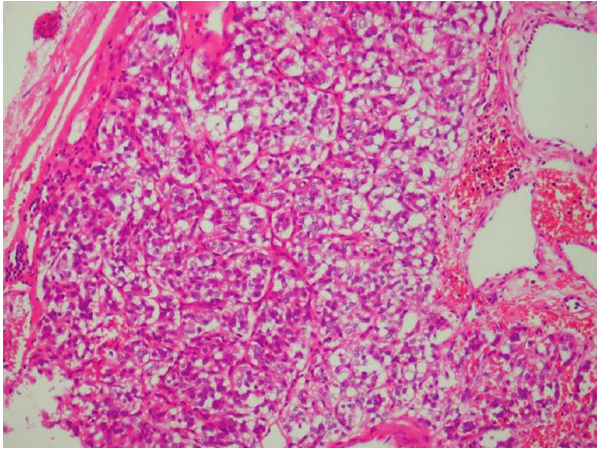
Figure 4 - Classic nesting pattern (Zellballen) of the paraganglioma of the present case Clusters of tumors cells are surrounded by capillaries in an organoid pattern (H & E, 100x)